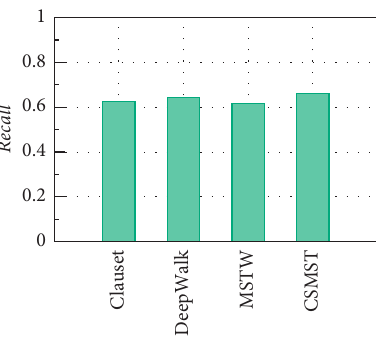
Figure 8: Comparison results on YouTube network.